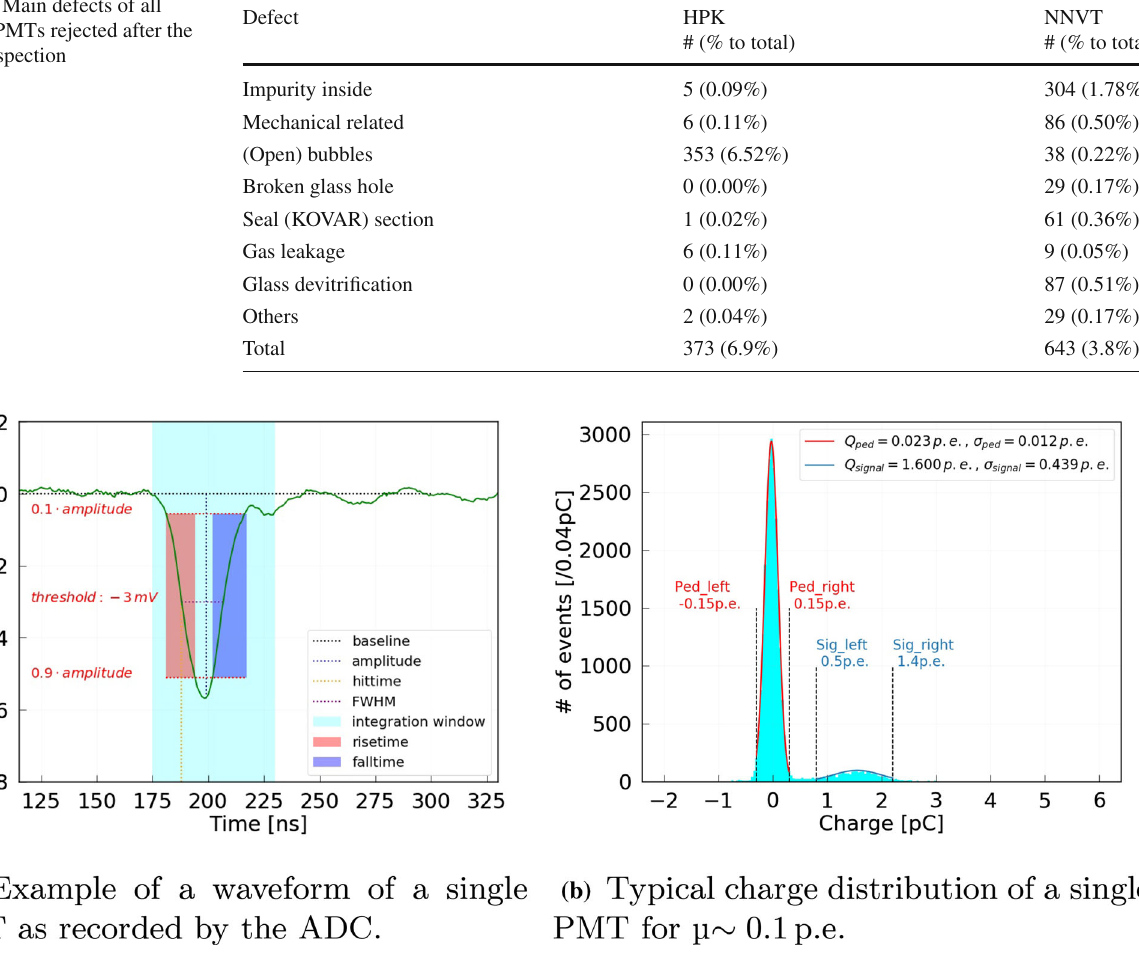
be fitted in the range [ 0 . 5 , 1 . 4 ] p.e. 13 ( Q sig and σ sig ). All